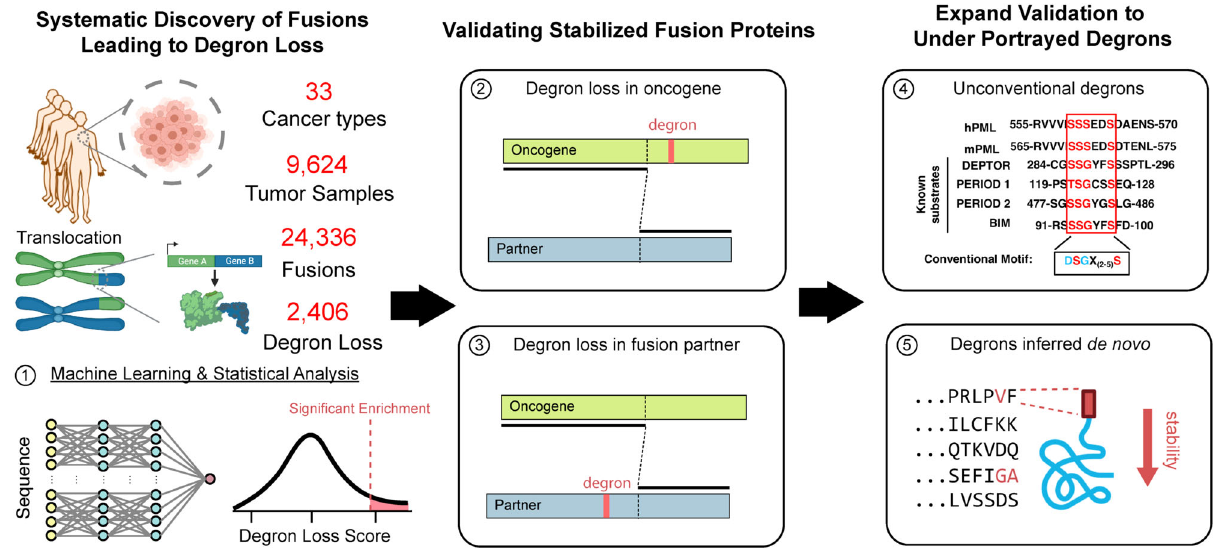
Fig. 1 Degron loss-prone genetic fusion events favor oncoprotein stabilization and tumorigenesis. A schematic diagram to illustrate the mechanism of how gene fusion leads to degron gain/loss event and thus perturbs proteins stability. Created with